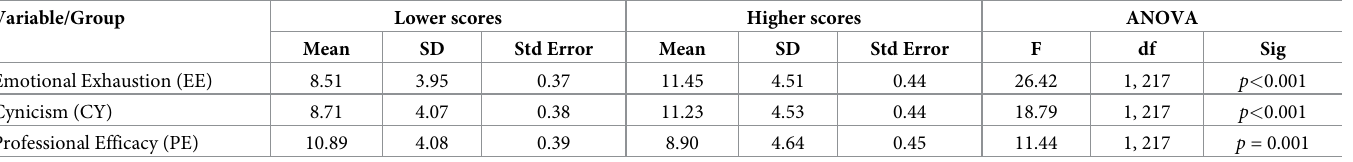
Table 3. Mean comparisons (ANOVA) of MBI factors between groups of correctional officers � . Variable/Group Lower scores Higher scores ANOVA Emotional Exhaustion